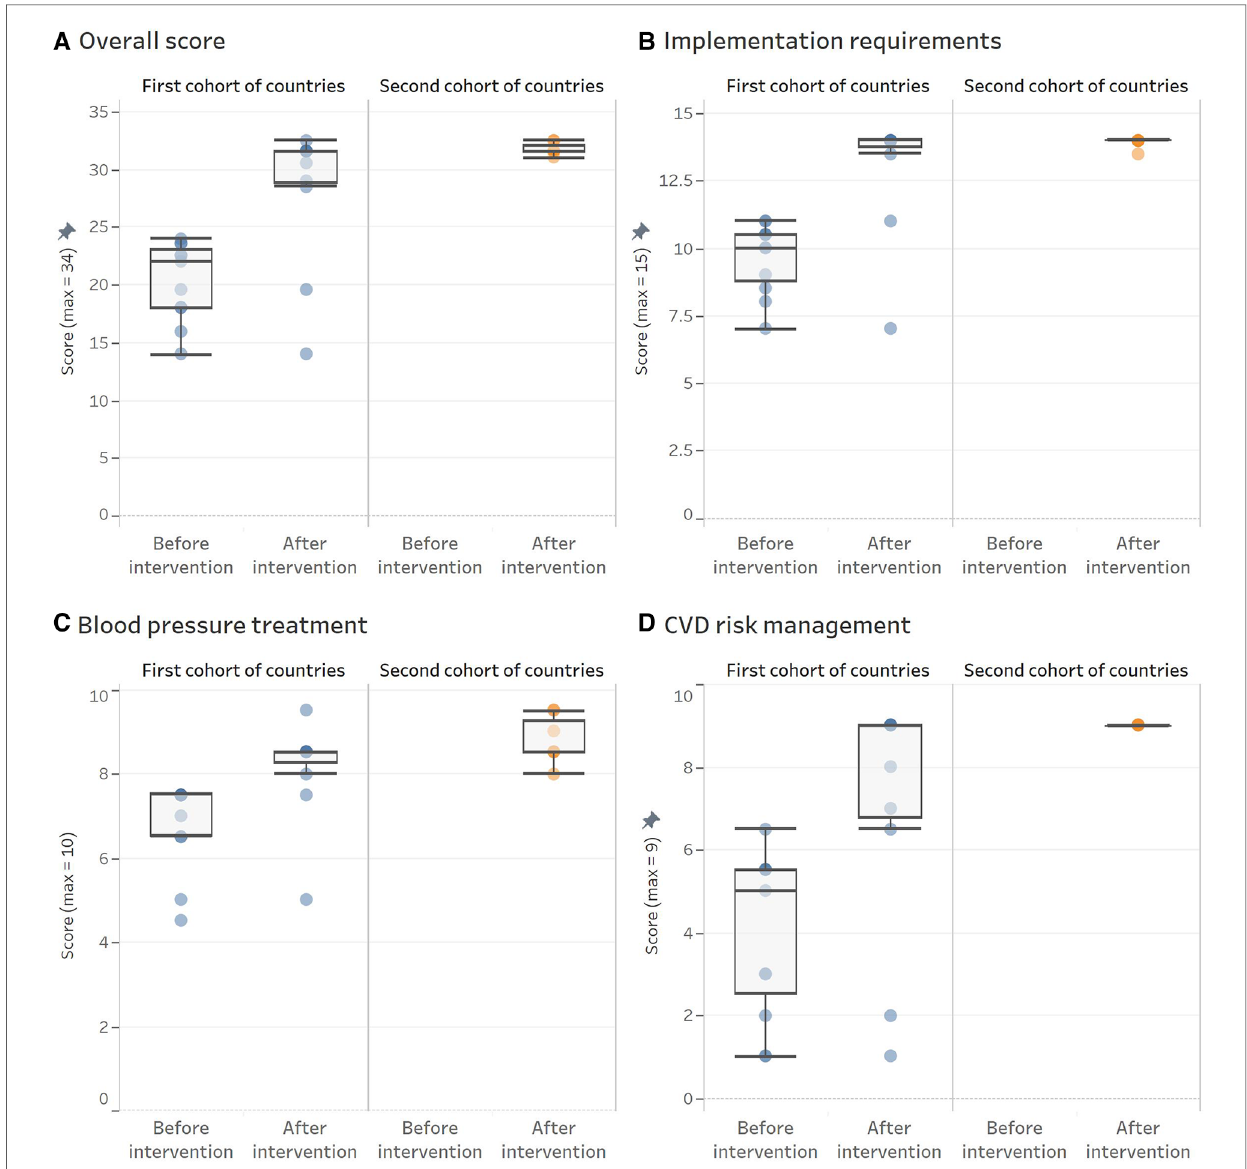
FIGURE 3 HEARTS appraisal checklist overall and domain-speci fi c scores obtained before and after the intervention by cohort of countries. ( A ) Overall score. ( B ) Implemenation requirements. ( C ) Blood pressure treatment. ( D ) CVD risk management. Each dot represents an evaluated protocol. The overimposed boxplots provide information about the central trend and variation before and after the intervention by cohort of countries. Panel A shows overall scores, and panel B , C , and D presents scores for each